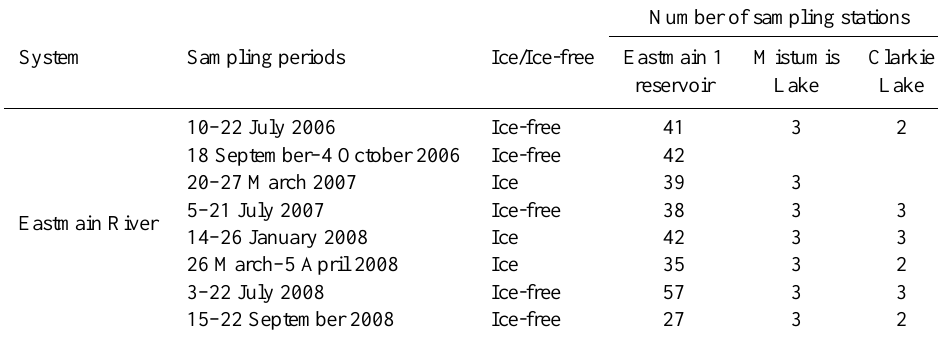
Table 2. Sampling periods and number of GHG (and water quality for Eastmain 1 reservoir and Mistumis Lake) sampling stations for each water body studied.